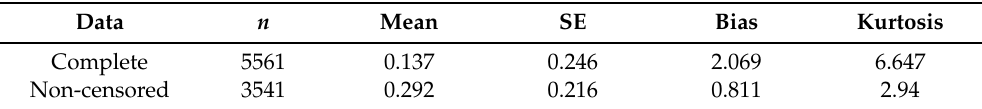
Table 1. Statistical summary of the infant deaths data.